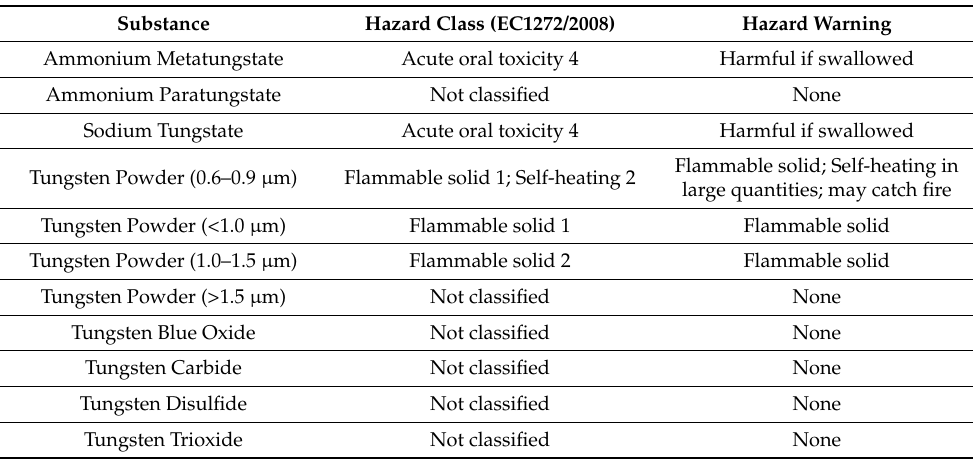
Table 5. Hazard classifications for the major tungsten substances. Based on: